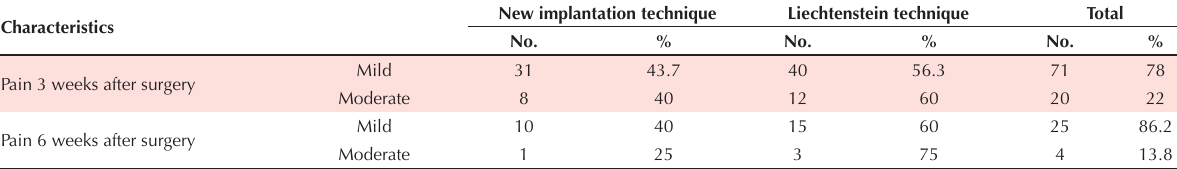
Table 3 . Frequency of pain severity in the two groups three and six months after surgery